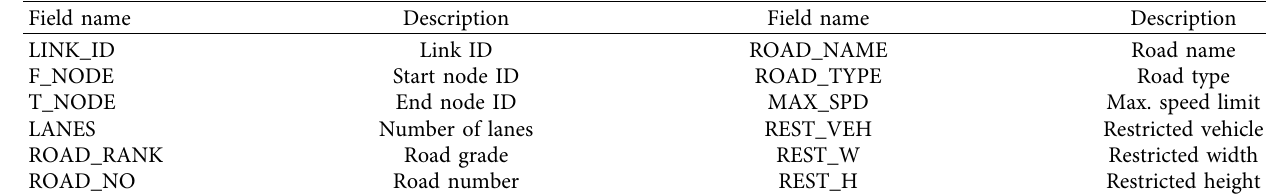
Table 1: Field items of standard link